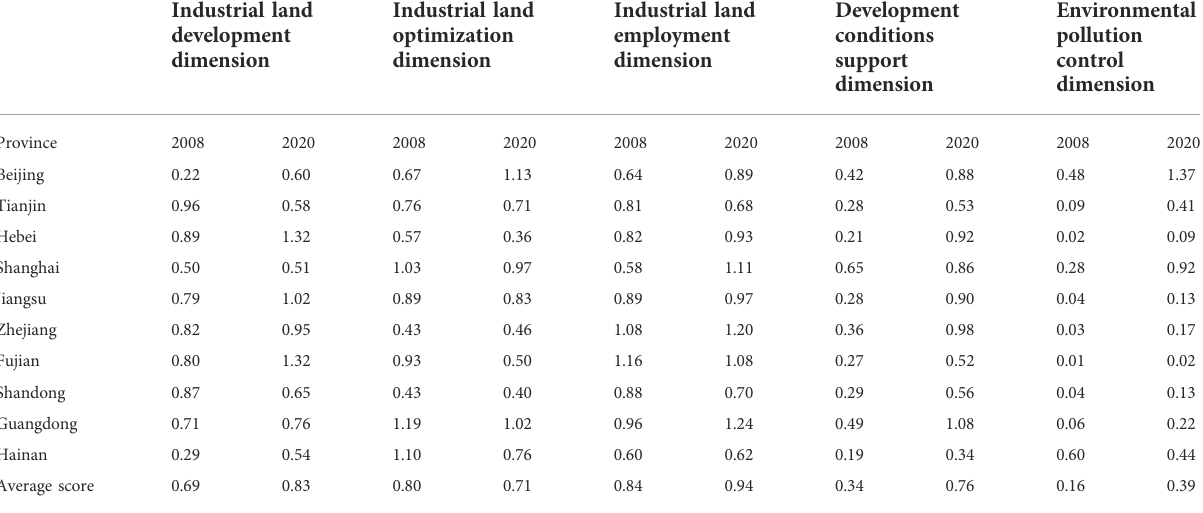
TABLE 3 Scores of Industrial land transformation effect in different dimensions (2008 –